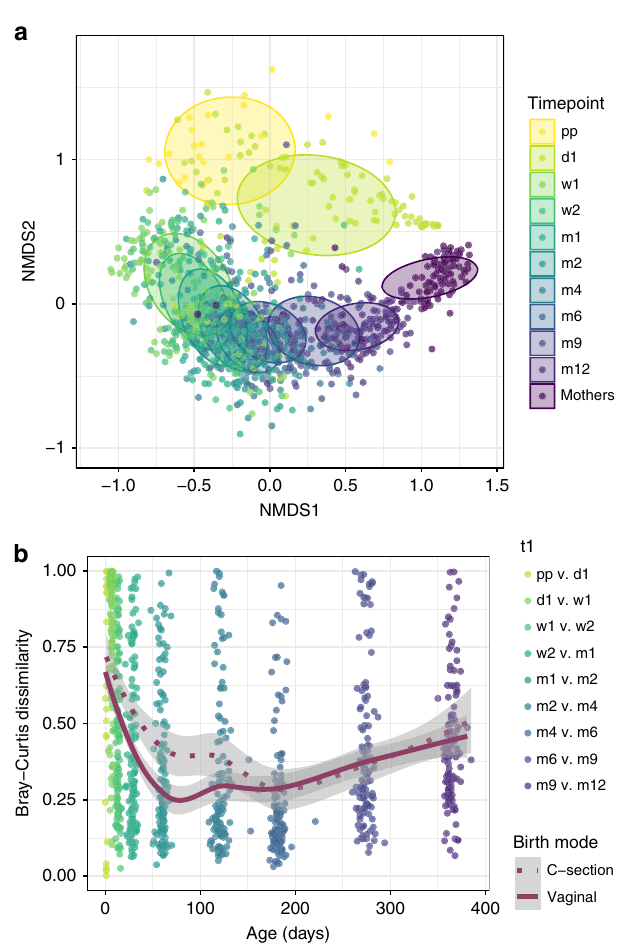
Fig. 1 Overall gut microbiota community composition development and stability. a Nonmetric multidimensional scaling (nMDS) plot, based on Bray – Curtis (BC) dissimilarity between samples, with data points and ellipses colored by timepoint. Children ’ s overall gut community composition developed toward a more adult-like pattern in the fi rst year of life, becoming more similar to microbiota of adults (mothers ’ samples, n = 87). b As measure of stability, we calculated BC dissimilarities between consecutive sample pairs belonging to an individual per time interval and plotted these at the end of each interval (t + 1). Loess lines were fi tted over the data points per delivery mode group, and the gray areas represent the 0.95 con fi dence intervals. Stability was signi fi cantly lower in C-section born infants until 2 months of life. Source data are provided as a Source Data fi